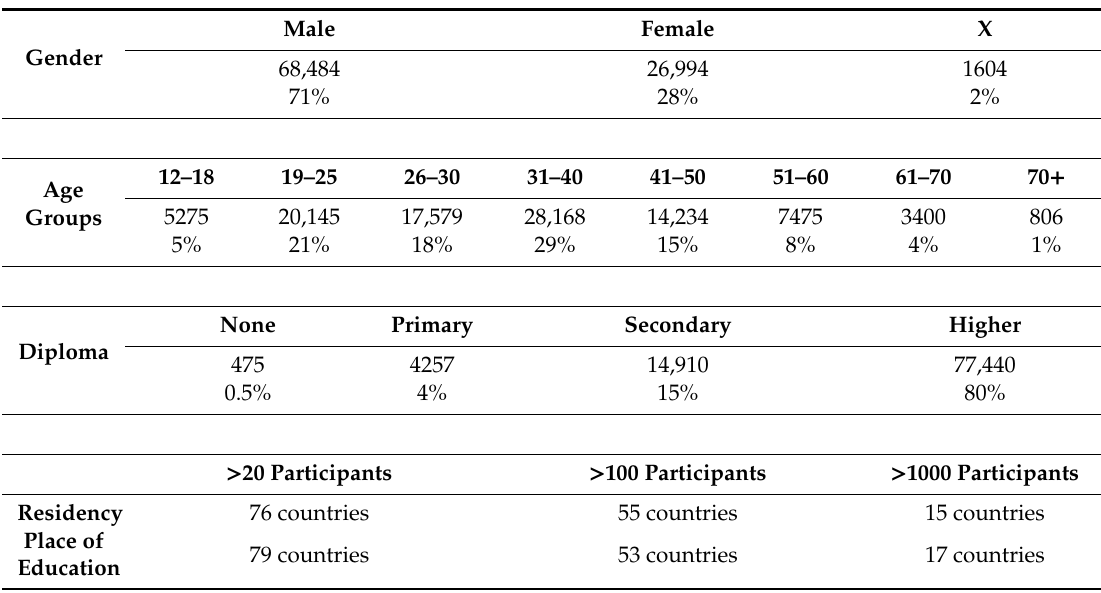
Table 1. Overview of the 97,082